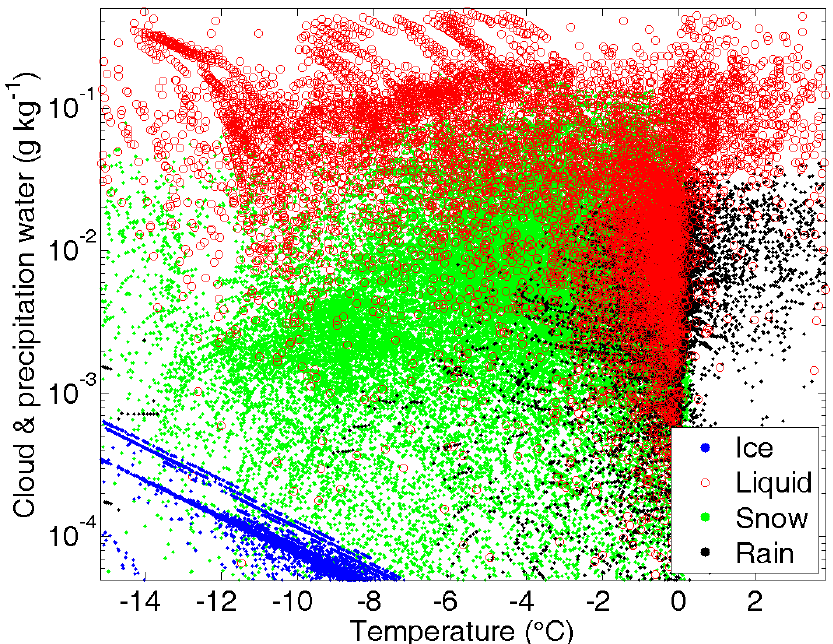
Figure 13. Scatter plot of (red) liquid, (blue) ice, (green) snow and (black) rain water mixing ratios, all in g kg −1 , against temperature for all the runs. Note that the green and black precipitation mixing ratios points are plotted under the cloud water mixing ratios to highlight the gap between liquid and ice cloud